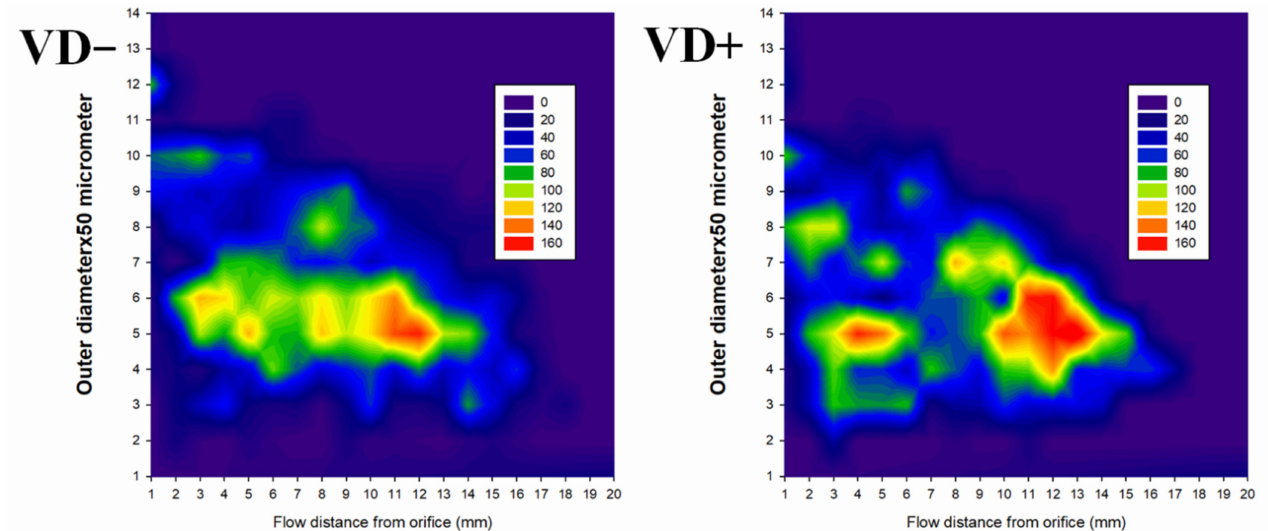
Figure 5. Frequency of ring units (color-coded) for different diameters and flow distances from the orifice. Note that in VD − rats a new population of 250 µ m units appears at a 6–9 mm flow distance from the orifice, while at the same locations there is a diminishment of 350 µ m units. In VD − rats, 150–200 and 300 µ m units are almost missing at 10–15 mm flow